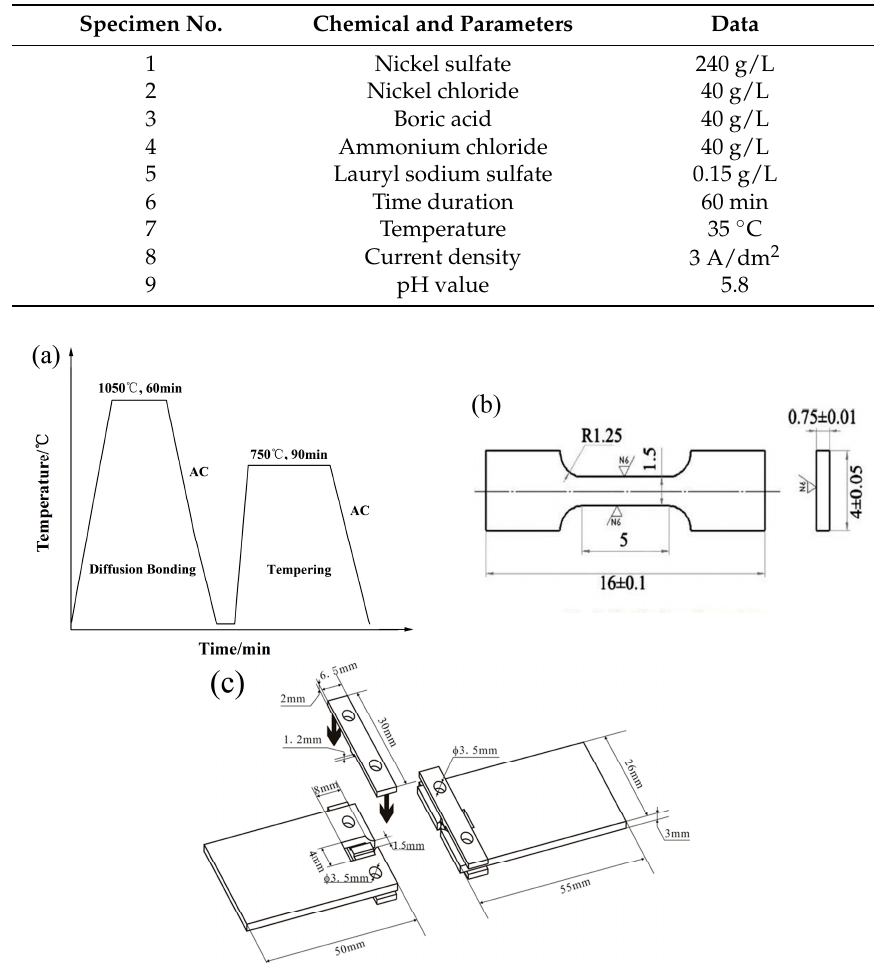
Figure 1. ( a ) Schematic diagram of diffusion bonding and tempering treatment of 9Cr martensitic/ferritic heat-resistant steel with an electrodeposited Ni interlayer; ( b ) schematic drawing of tensile specimen; ( c ) schematic drawing of clamping